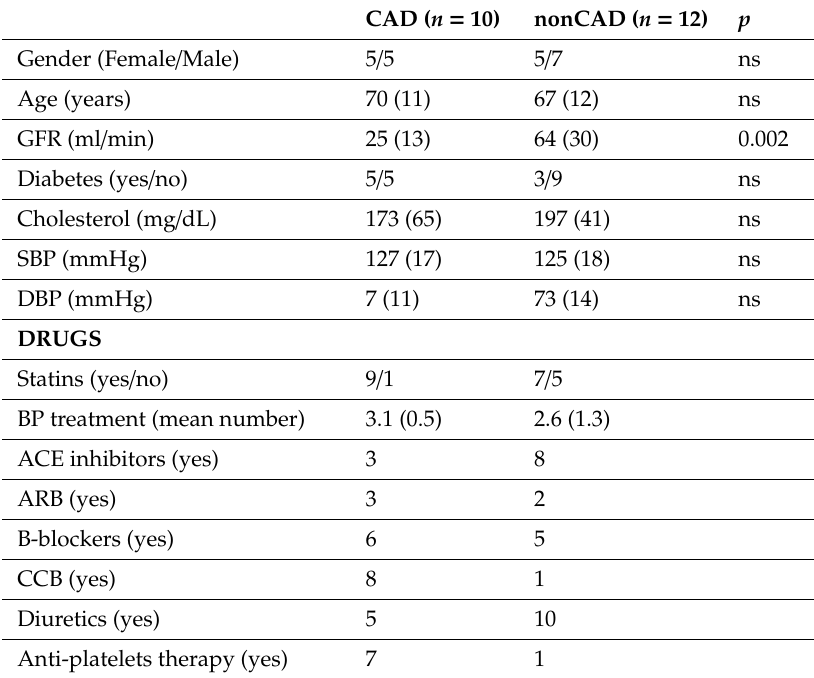
Table 4. Demographics and Clinical characteristics of patients. Abbreviations: CAD = Coronary artery disease, NonCAD = patients without CAD, GFR = Glomerular Filtration Rate, calculated by CKD-EPI method, SBP = Systolic Blood Pressure, DBP = Diastolic Blood Pressure, BP = Blood Pressure, ACE = Angiotensin-converting-enzyme, ARB = Angiotensin-Receptor Blockers, CCB = Calcium Channel Blocker. Diabetes was considered if patients were taking antidiabetic treatment. p value was calculated with the nonparametric Mann-Whitney U test. Standard deviation shown in parenthesis for the cholesterol, SBP and DBP values. Demographics and Clinical Characteristics of